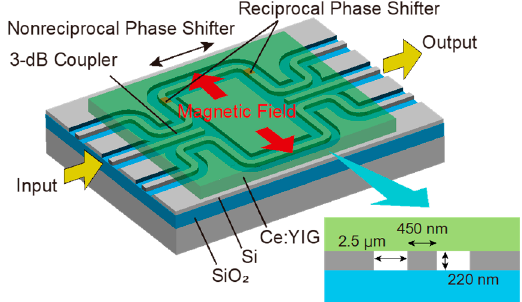
Figure 1. Schematic of Mach–Zehnder interferometer (MZI)-based optical isolator with magneto-optical (MO) upper cladding layer. Si waveguides are 450-nm wide and 220-nm high. 3 × 2 couplers function as 3-dB power splitter and combiner with directional coupling among three adjacent waveguides.